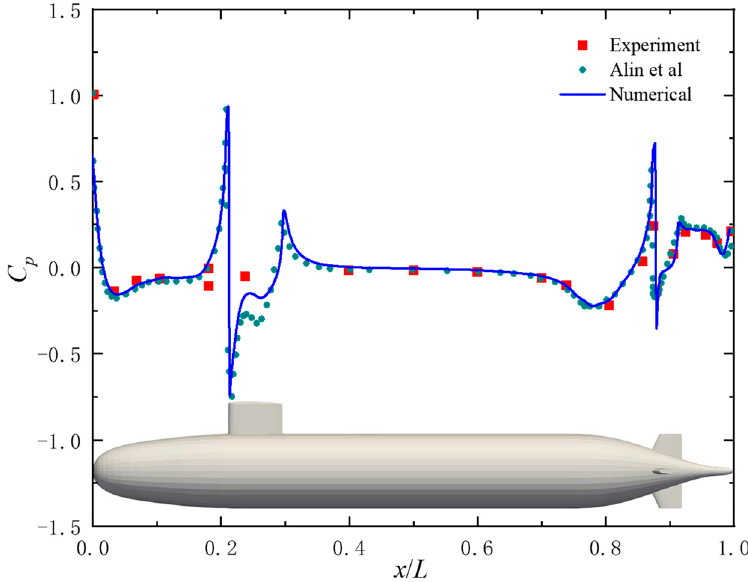
Figure 8. Nondimensional pressure coefficient distribution along SUBOFF-AFF-8.